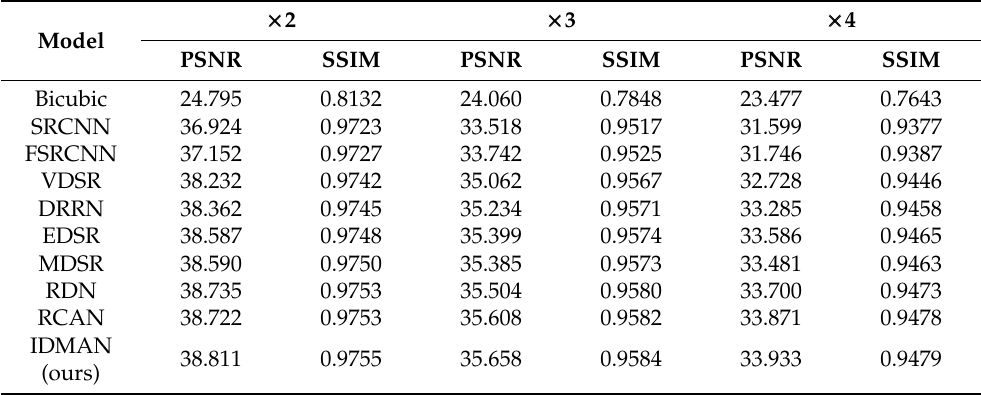
Table 7. The average PSNR and SSIM results of different algorithms in NSCLC Radiogenomics